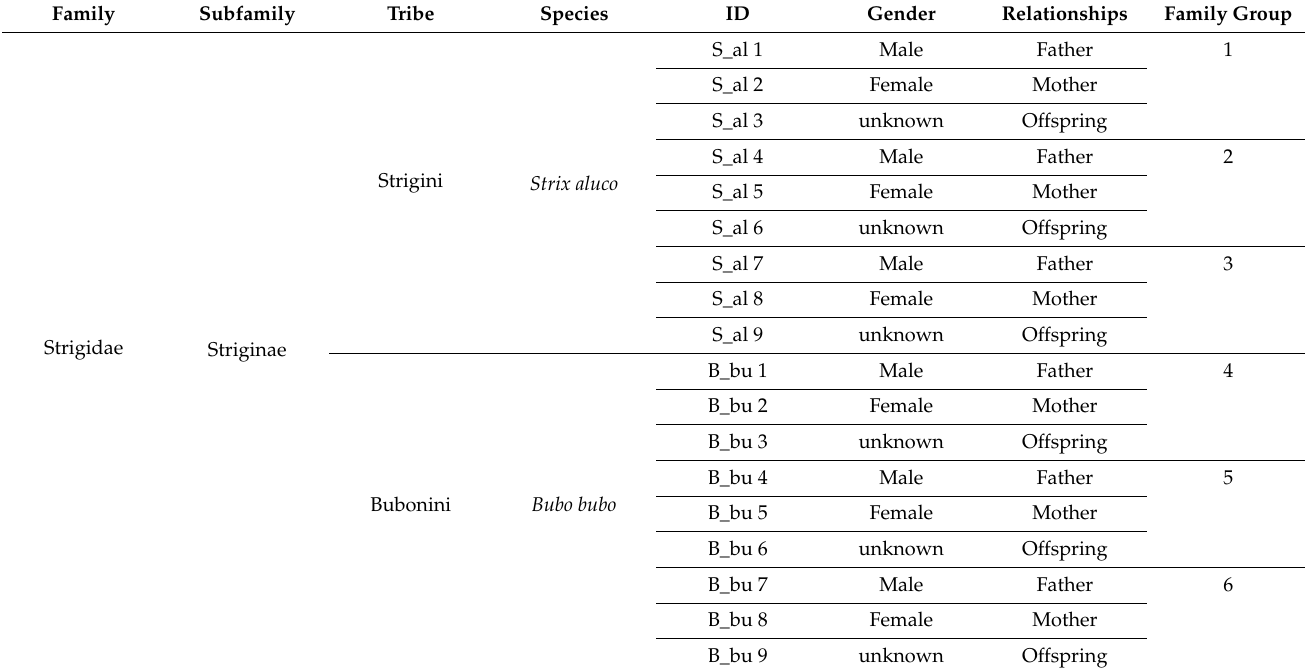
Table 1. List of species and individuals used in each step: family groups from 1 to 9 were tested in the first and second screening; additional species and family groups (from 10 to 28) were tested in the third step.